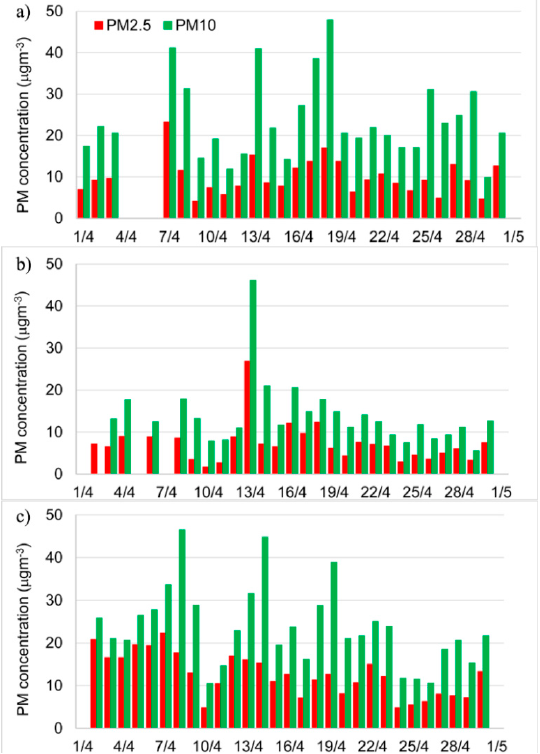
Figure 2. PM 10 , PM 2.5 concentrations at ( a ) CGR, ( b ) LMT and ( c ) ECO observatory, respectively.